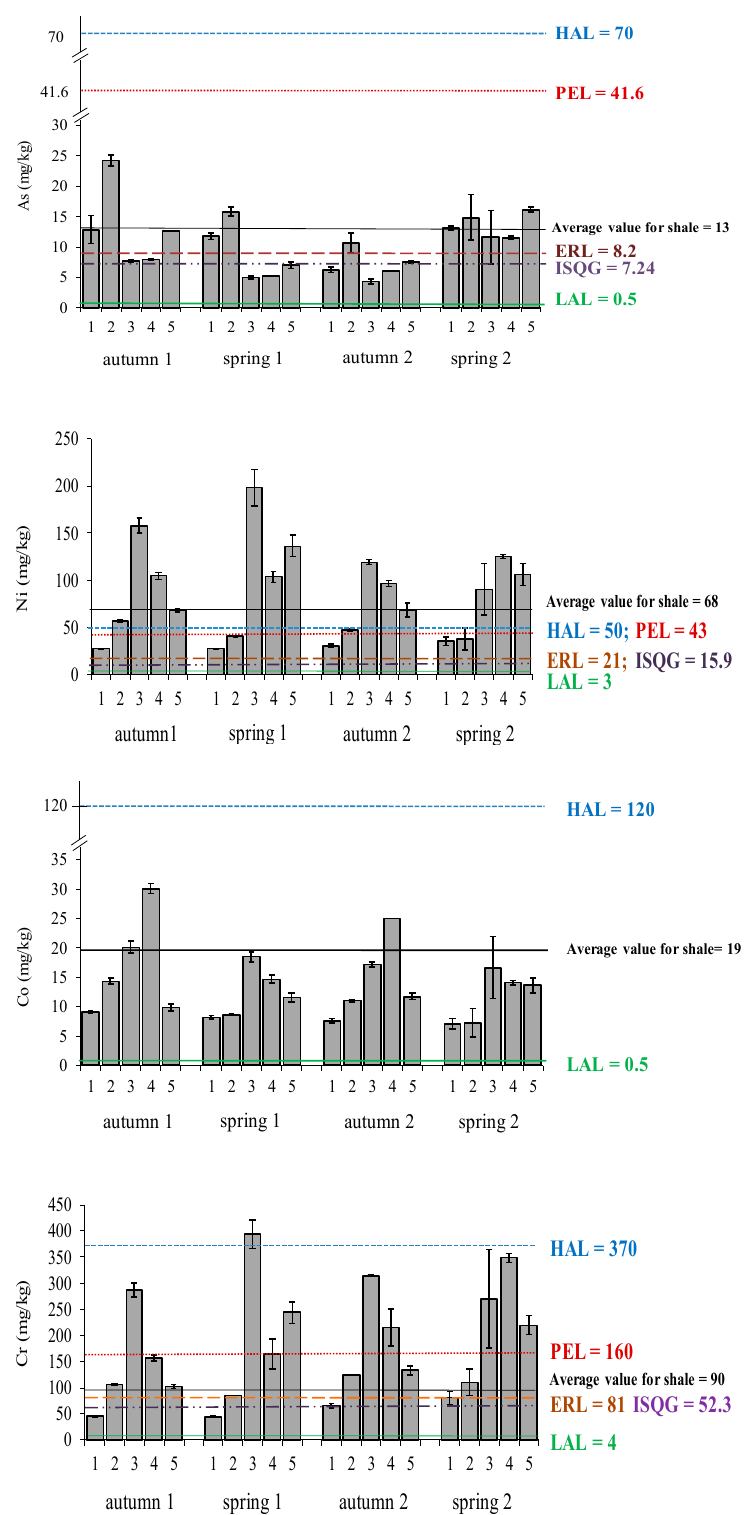
Figure 10. Total metal concentrations in sediments and comparison with quality guidelines (Low alert levels (LAL), effect range low (ERL), Interim Sediment Quality Guideline (ISQG), High Alert Level (HAL), Probable Effect Level (PEL) and average values for continental shale).